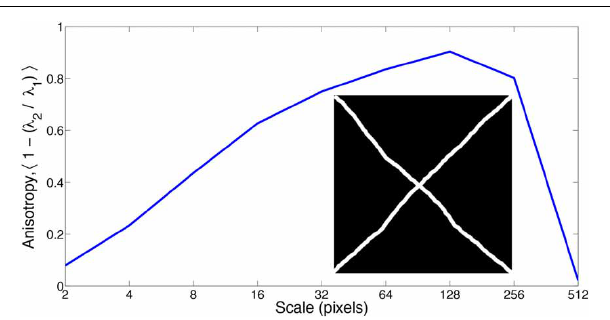
FIGURE 2 | Example of a synthetic image and its analysis. In insert : artificial image (512 × 512 pixels) consisting in a cross loosely following the diagonals of a square. The lines are about 11 pixels wide. The main graph represents the anisotropy as a function of the scale.